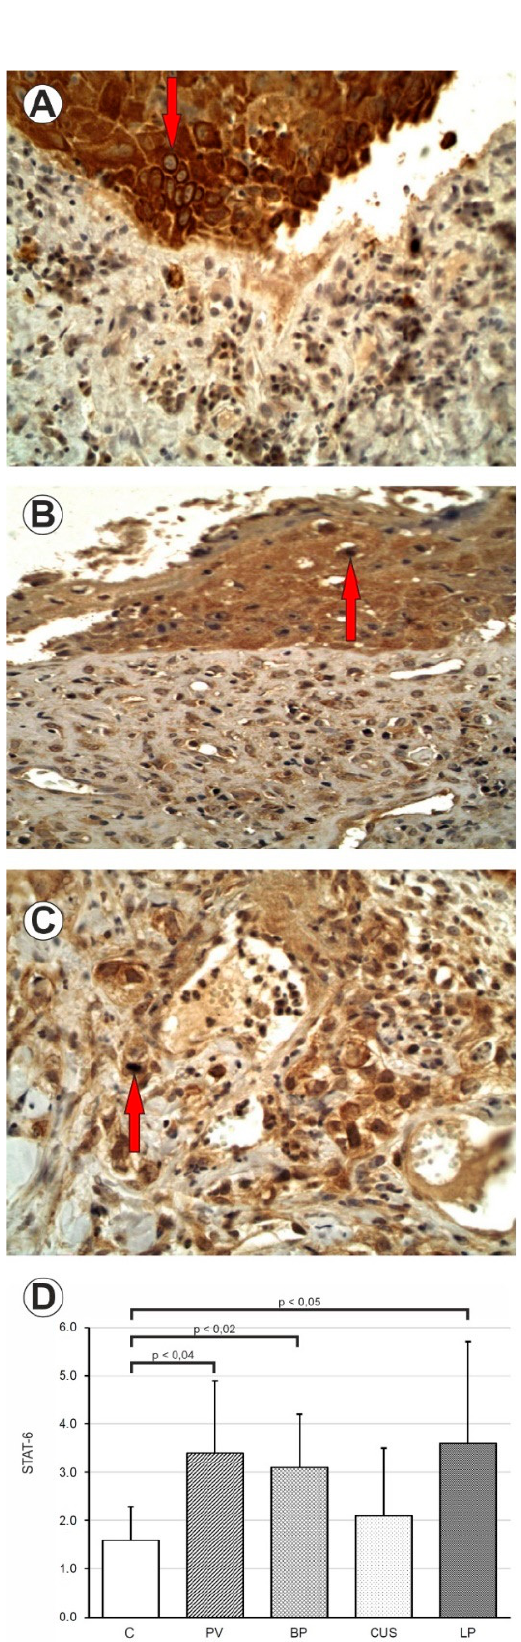
Figure 2. ( A ) Immunohistochemistry. STAT6 expression in epithelial cells and inflammatory influx. PV. 400× mag. ( B ) Immunohistochemistry. STAT6 expression in epithelial cells and inflammatory influx. BP. 400× mag. ( C ) Immunohistochemistry. STAT6 expression in epithelial cells and inflammatory influx. LP. 400× mag. ( D ) Comparison of STAT6 in PV, BP, CUS, LP and healthy mucosa ( C ).